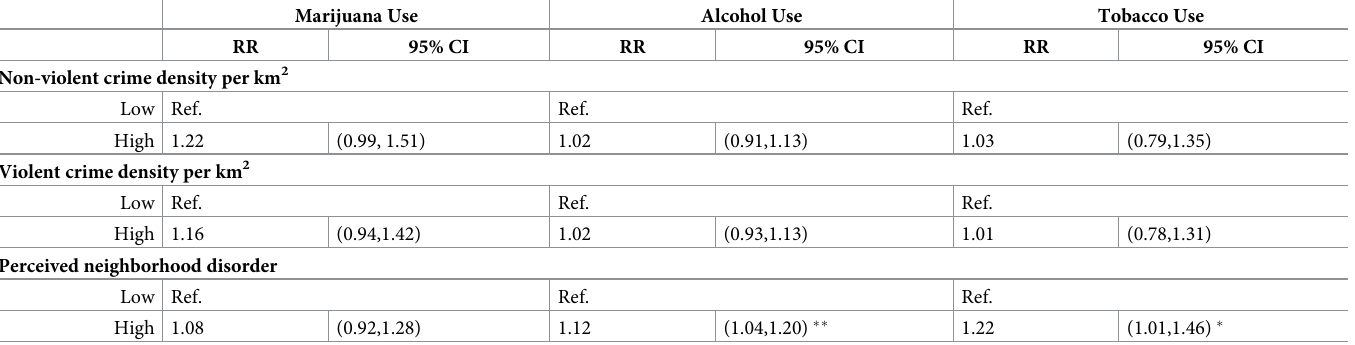
Table 2. Adjusted relative risks and 95% confidence intervals between neighborhood crime densities and perceived neighborhood disorder and current substance use 1 .